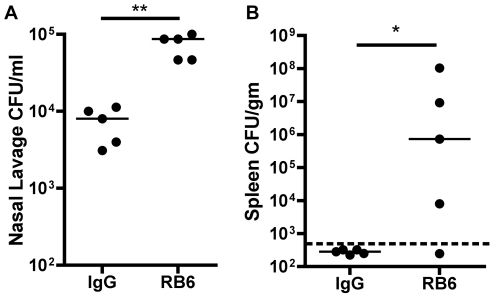
Neutrophils inhibit K. pneumoniae colonization and prevent bacteremia.Mice were treated with RB6-8C5 rat mAb to murine Ly6G or control rat IgG one day prior to inoculation with 2×106 cfu of wild-type K. pneumoniae KPPR1 were sacrificed at day 1 post-inoculation. Nasopharyngeal lavage cfu/ml (A) and spleen cfu/gm (B) are shown as a scatter plot with the bar at the median; dashed line represents lower limit of detection. ** p<0.01 by Mann-Whitney test; * p<0.05 by Fisher's Exact Test for presence of detectable bacteria in the spleen.